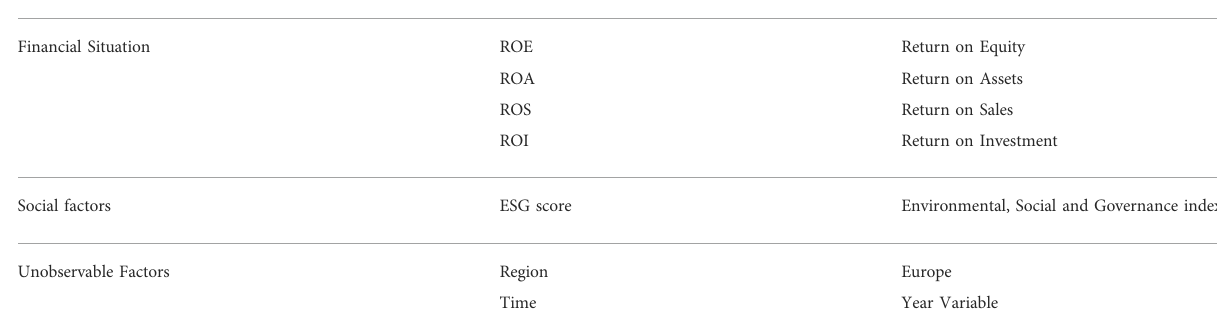
TABLE 3 Latent variables and observable variables: Source Own elaboration.